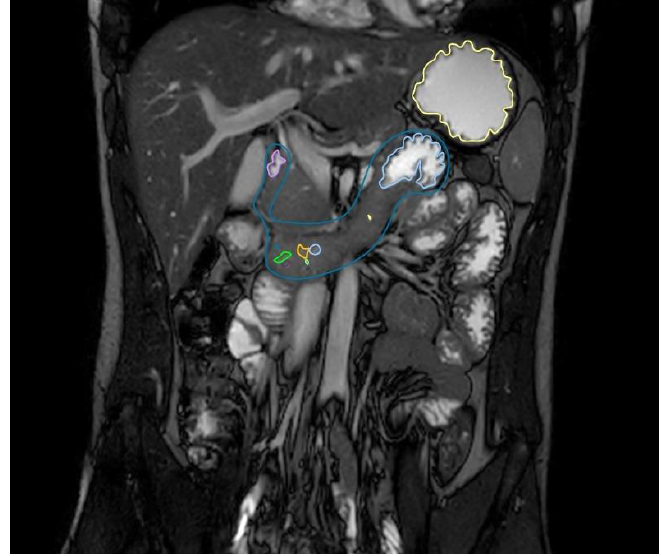
Figure 1. MRI TrueFISP sequence image in the coronal plane; the stomach (yellow outline) and duodenum (dark-blue outline) with the fluid pockets outlined in different colours.